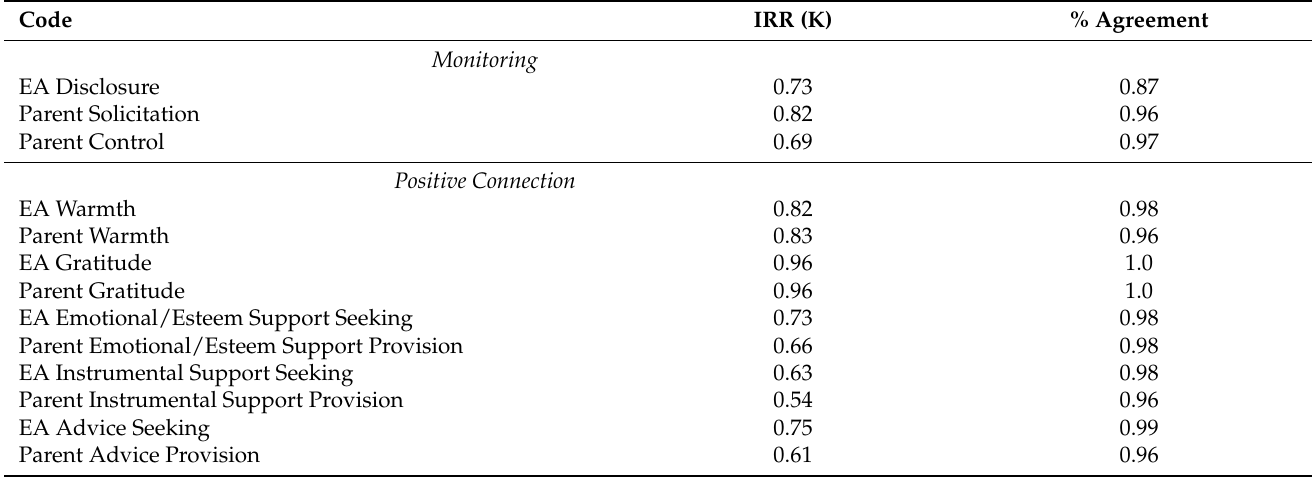
Table 2. Interrater